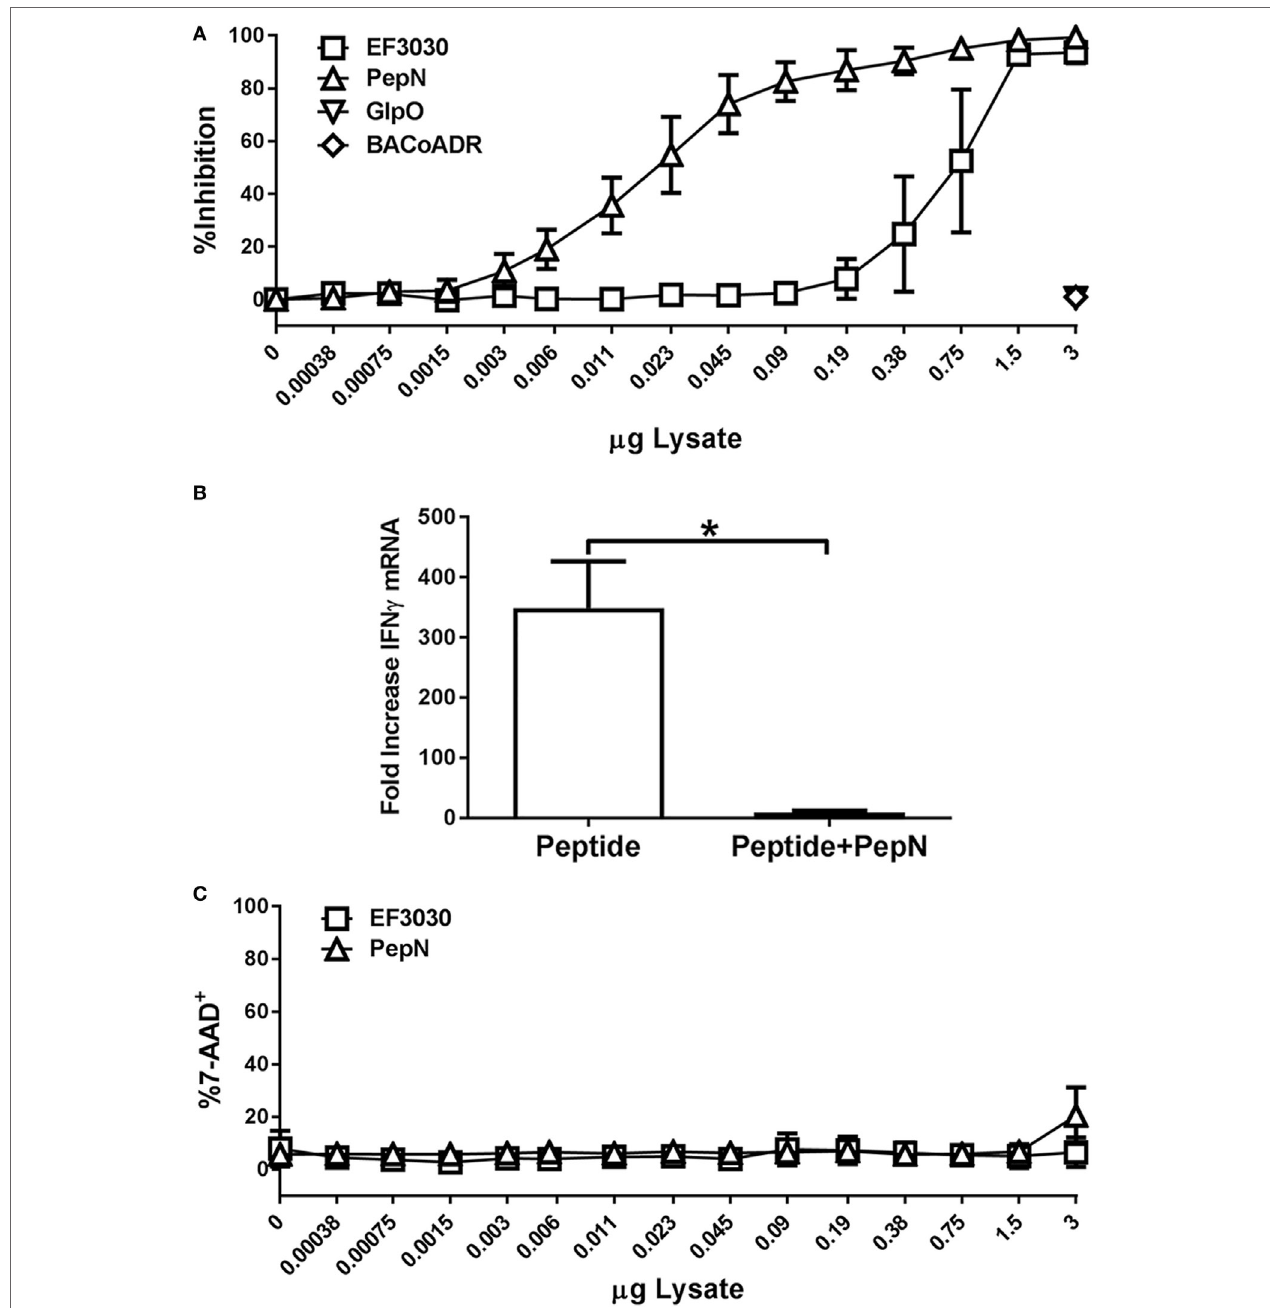
FigUre 6 | Purified aminopeptidase N (PepN) shows enhanced T cell inhibitory activity relative to Streptococcus pneumoniae ( Spn ) lysate and this effect is independent of toxicity. NP-specific cytotoxic T lymphocyte (CTL) were stimulated with peptide in the presence of increasing amounts of EF3030-derived lysate or purified PepN. Following stimulation, cells were stained with anti-CD8 and anti-IFN γ antibodies. 7-AAD was used to assess cell viability. (a) Mean ± SEM for PepN inhibition of IFN γ production. (b) Mean ± SEM of IFN γ mRNA following treatment of CTL with PepN. (c) Cell viability data are represented as the mean ± SEM. Data are from three independent experiments using at least two independently generated NP-specific CTL